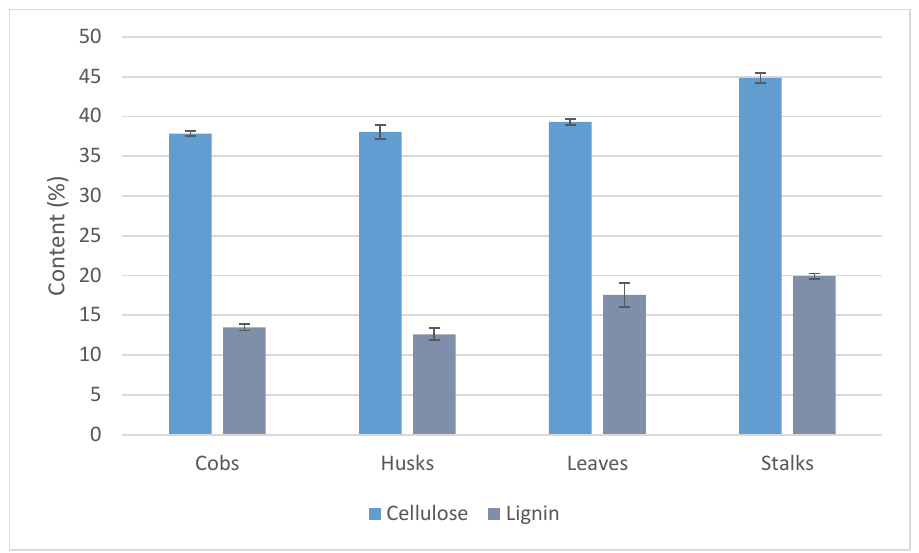
Figure 2. Cellulose and lignin contents in maize stover fractions according to [3].